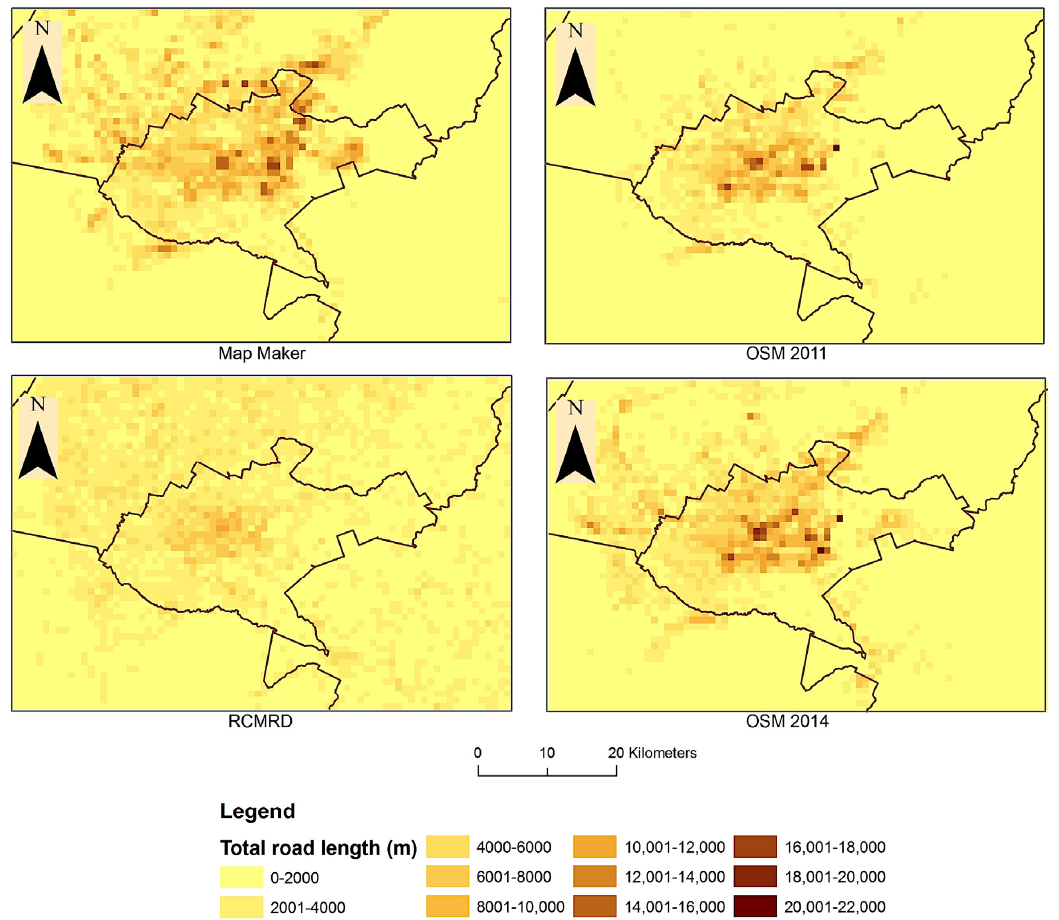
Figure 4. Road coverage per km 2 .